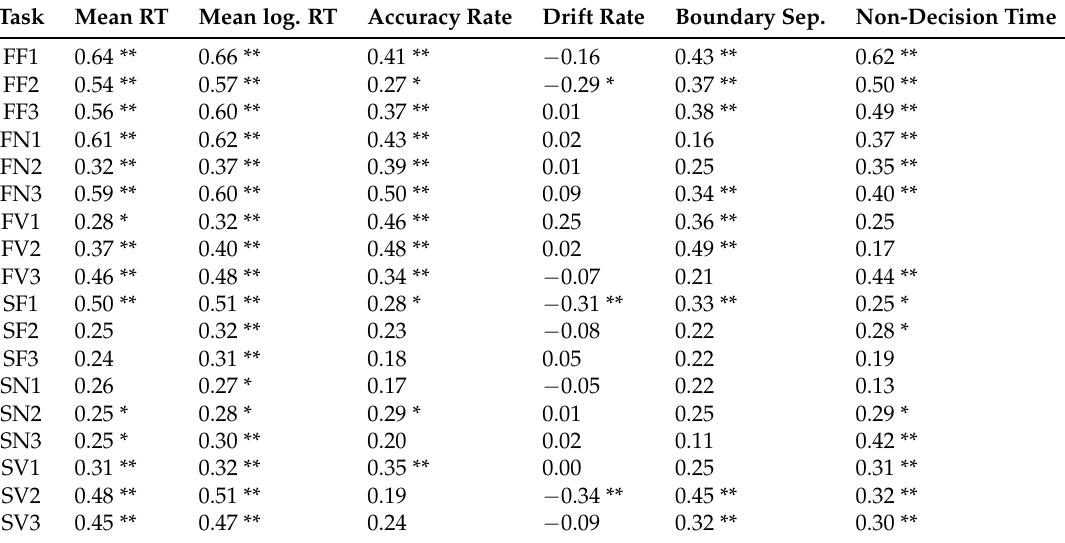
Table 3. Age correlations of RTs, accuracy rates, and diffusion model parameters for all 18 RT